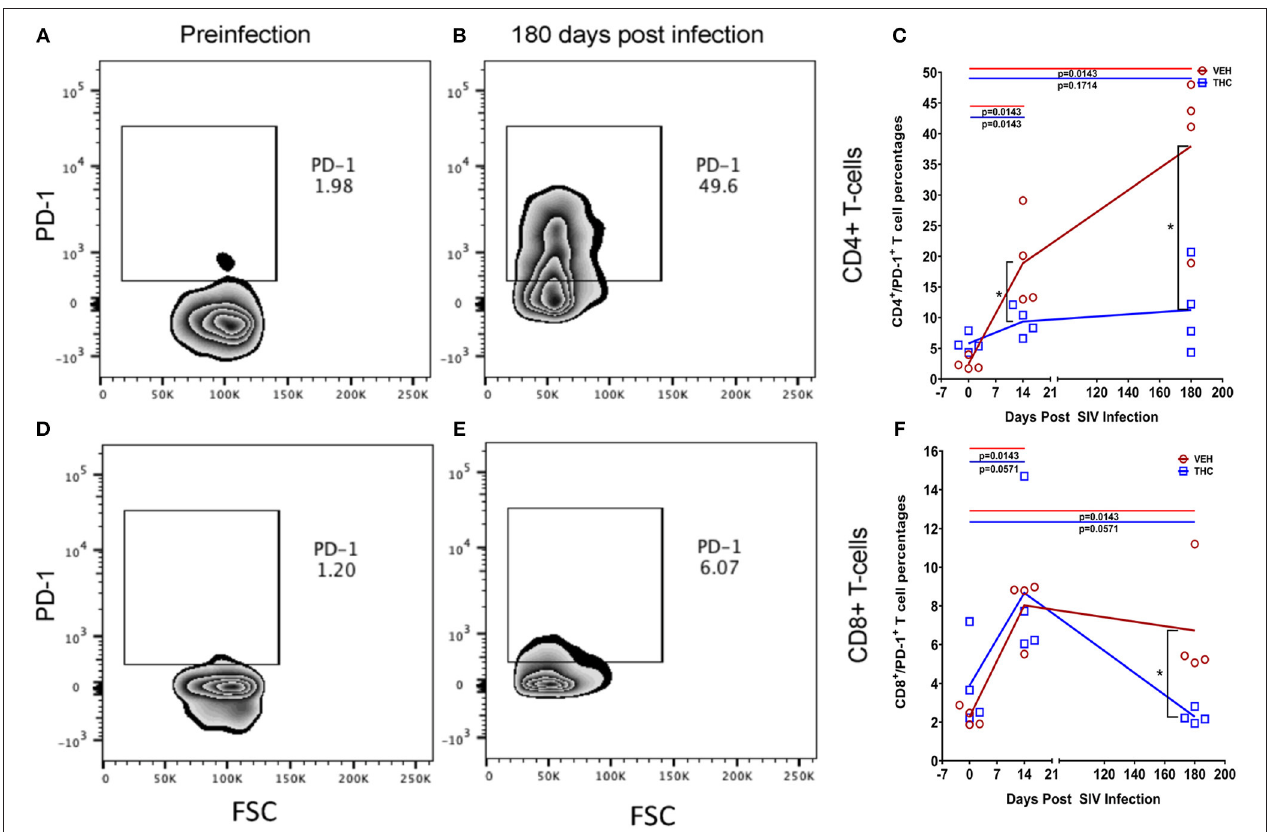
FIGURE 8 | Delta-9-tetrahydrocannabinol ( 1 9 -THC) administration inhibited PD-1 expression in intestinal T cells after SIV infection. Zebra plot shows significantly high expression of programmed death 1 (PD-1) by intestinal CD4 + T cells in a VEH/SIV rhesus macaque at 180 days post infection compared to preinfection time point (A,B) . In contrast, PD1 expression in intestinal CD4 + T cells is significantly reduced in THC/SIV rhesus macaques at 14- and 180-days post-SIV infection compared to VEH/SIV rhesus macaques (C) . Zebra plot shows PD-1 expression on intestinal CD8 + T cells of a VEH/SIV rhesus macaque at 180 days post-infection (D,E) . Like CD4 + T cells, the percentage of PD-1 expressing CD8 + T cells out of total CD8 + T cells was also significantly reduced in THC/SIV rhesus macaques at 180 days post-SIV infection compared to VEH/SIV rhesus macaques (F) . Open red circles- VEH/SIV, Open blue squares- THC/SIV. Horizontal red and blue lines with P -values denote comparisons between time points within the VEH/SIV and THC/SIV groups, respectively. Left black brackets with an asterisk indicate statistical significance ( p = 0.0143) between the VEH/SIV and THC/SIV groups for a given time point. Connecting blue and red lines (C,F) denote mean values of the respective population in the THC/SIV and VEH/SIV groups, respectively. Flow cytometry analysis to determine the effect of 1 9 -THC on PD-1 expression in intestinal CD4 + and CD8 + T cells of SIV-infected rhesus macaques was performed once with four individual animals as biological replicates per group. Flow cytometry data were analyzed using linear mixed models with immune-marker outcomes being dependent variables, and treatment status (VEH vs. 1 9 -THC) and days since the start of treatment (0, 14, 120, 180) being independent variables with fixed effects. Differences between two time points were analyzed using the Mann-Whitney U -test employing the Prism v5 software (GraphPad software). A p -value of ≤ 0.05 was considered